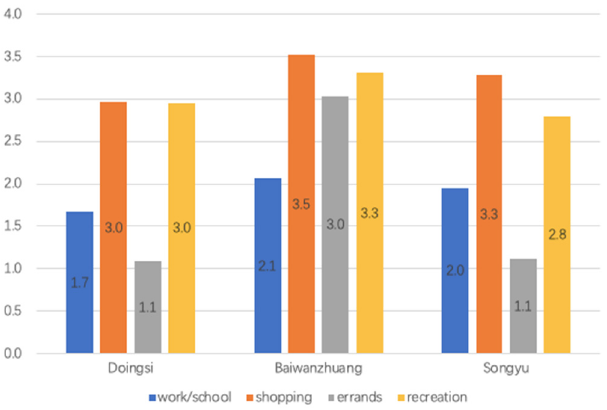
Figure 9. The amount of days people conduct PA in a general week in three neighborhoods.